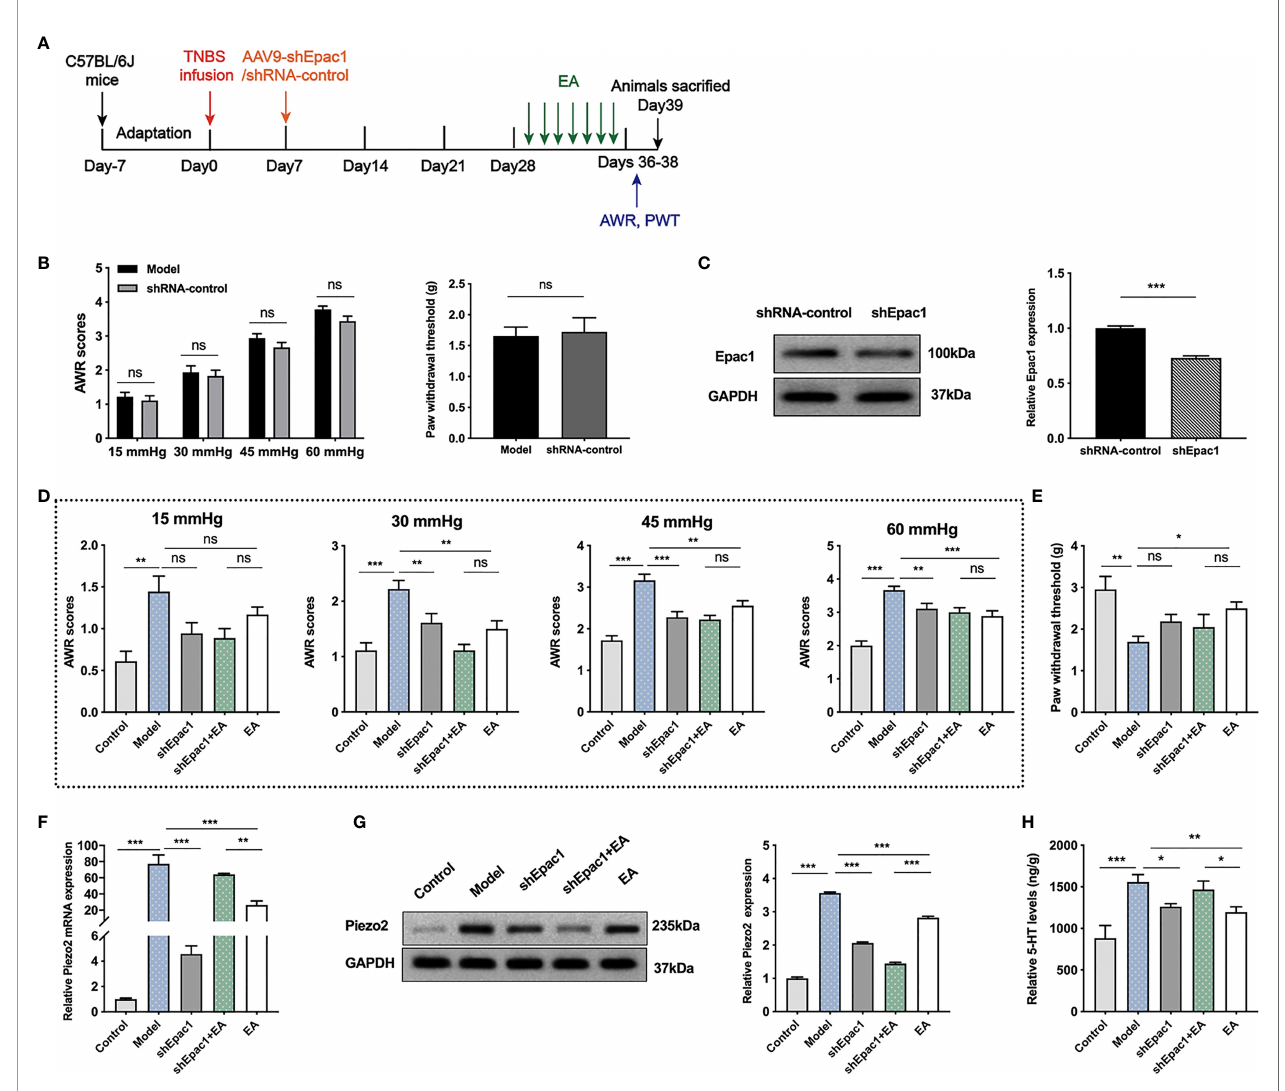
FIGURE 5 | Knockdown of colonic Epac1 didn ’ t in fl uence the effect of EA. (A) Schedule of the experimental procedures. (B) Abdominal withdrawal re fl ex and hind paw withdrawal threshold evaluated between the model and shRNA-control groups (n=6 per group). (C) Representative Western blot analyses of Epac1 staining and relative protein levels between the shRNA-control and shEpac1 groups (n=3 per group). (D, E) Abdominal withdrawal re fl ex scores and hind paw withdrawal threshold evaluated in each group (n=6 per group). (F) Relative colonic Piezo2 mRNA expression (n=3 per group). (G) Representative Western blot analyses of Piezo2 staining and relative protein levels in the colonic tissues (n=3 per group). (H) ELISA analysis of 5-HT in colonic tissues (n=6 per group). Data are presented as mean ± SEM; (B) two-tailed Mann – Whitney test for AWR, t test for PWT; (C) two-tailed t test; (D-H) One-way ANOVA with LSD multiple comparisons test; * P < 0.05, ** P < 0.01, *** P < 0.001, ns P